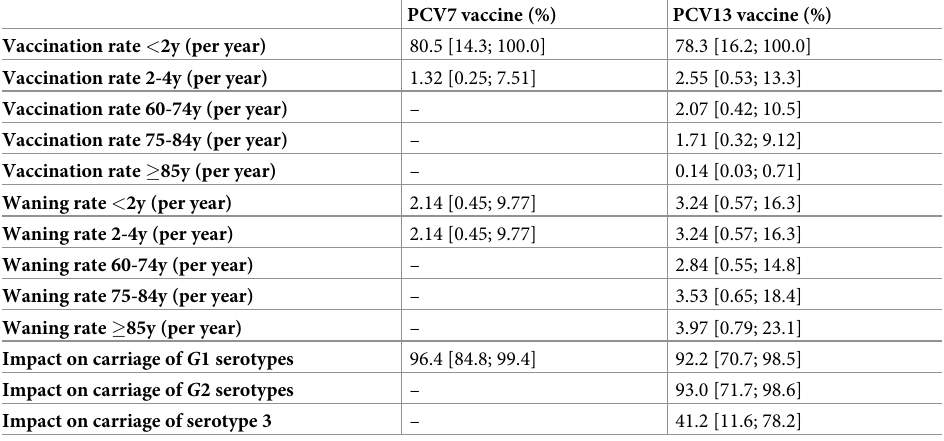
Table 2. Estimated parameters of the vaccination model (with 95% CIs) in